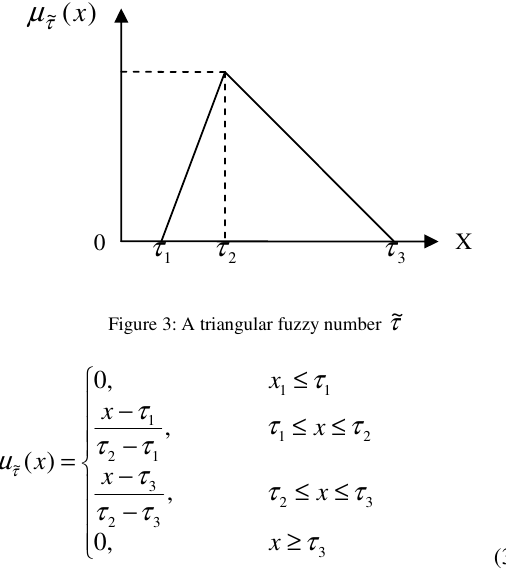
Figure 3: A triangular fuzzy number τ